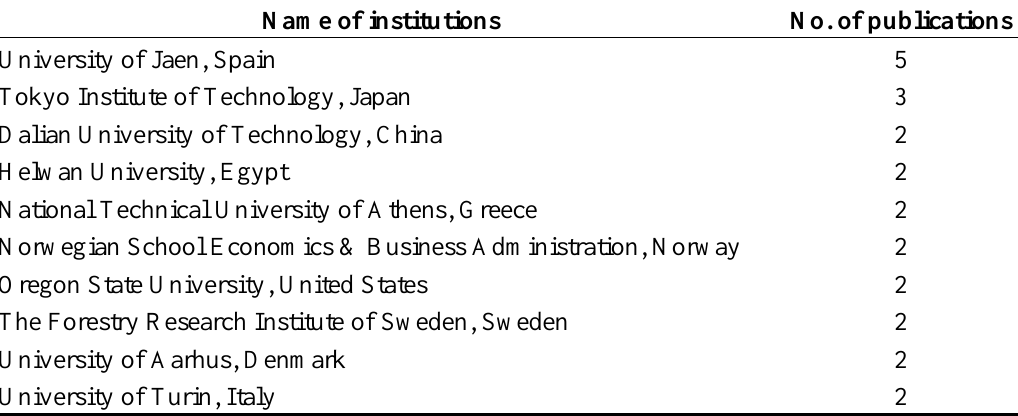
Table 3. Top ten institutions by contributions.